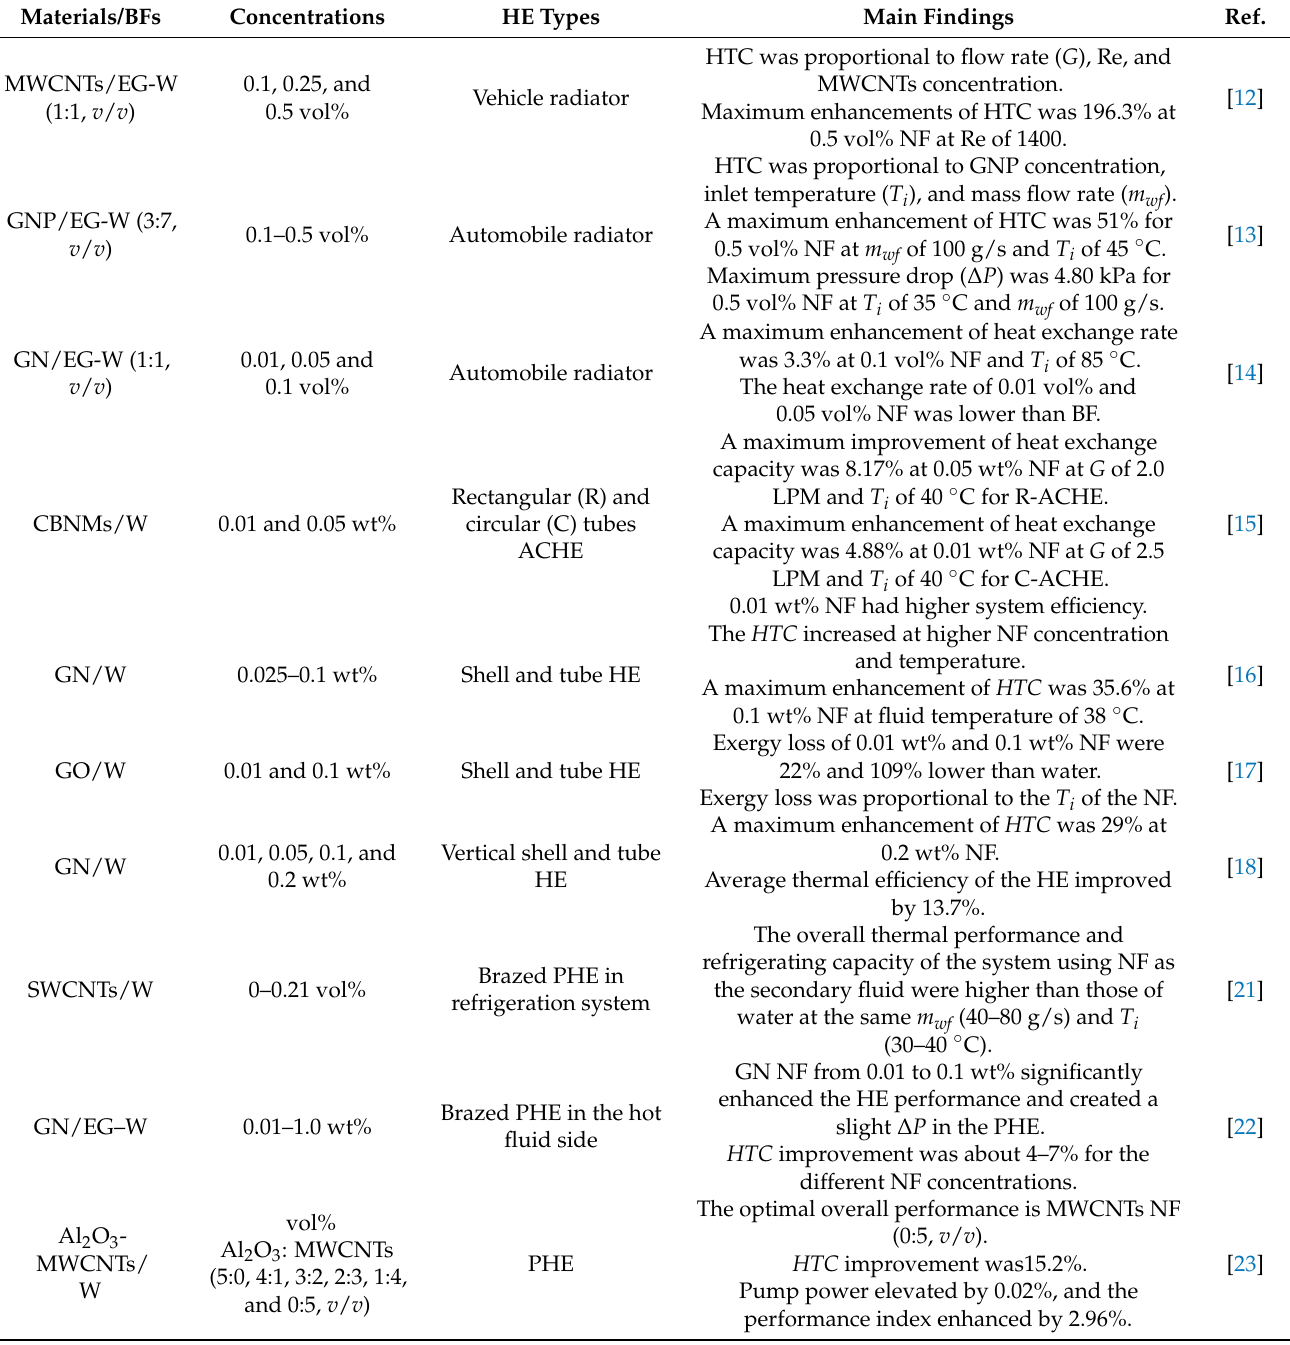
Table 1. List of experimental results on the use of CBNFs in different heat